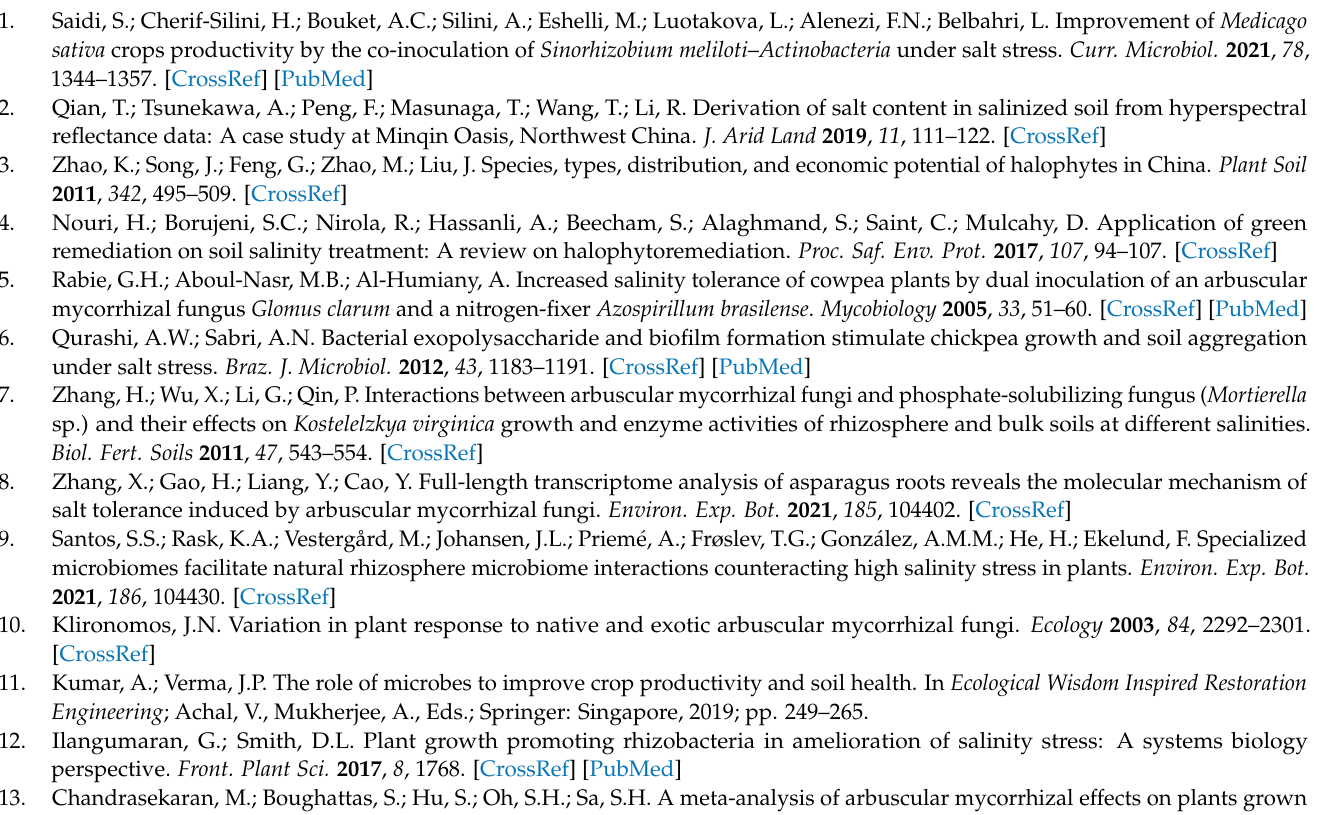
indices. Figure S1: Relationships between Na + and succulence degree in Nitraria tangutorum Bobr. and Elaeagnus angustifolia Linn. seedlings under saline soil conditions. Figure S2: Correlation coefficients among different nutrient parameters in the leaf and root of Nitraria tangutorum Bobr. seedlings. Figure S3: Correlation coefficients among different nutrient parameters in the leaf and root of Elaeagnus angustifolia Linn.